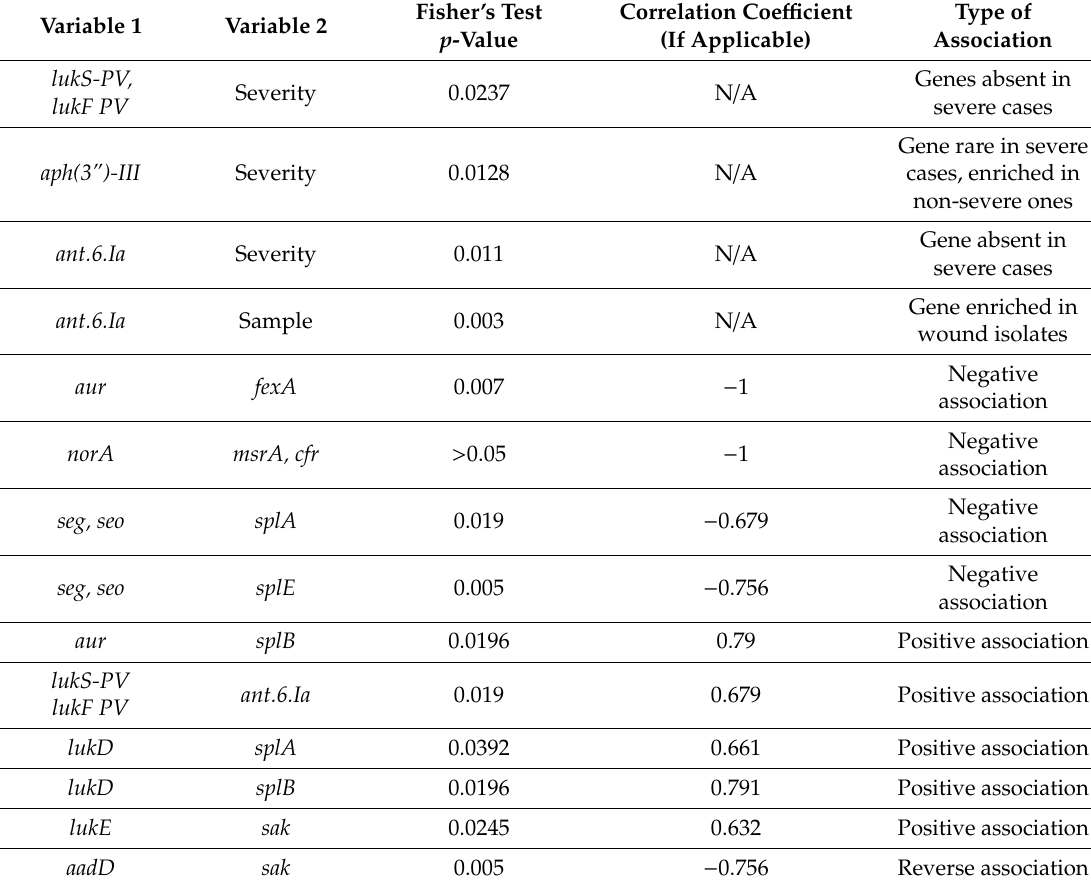
Table 5. Selected statistically significant associations between pairs of variables (a full list in Supplementary Data File